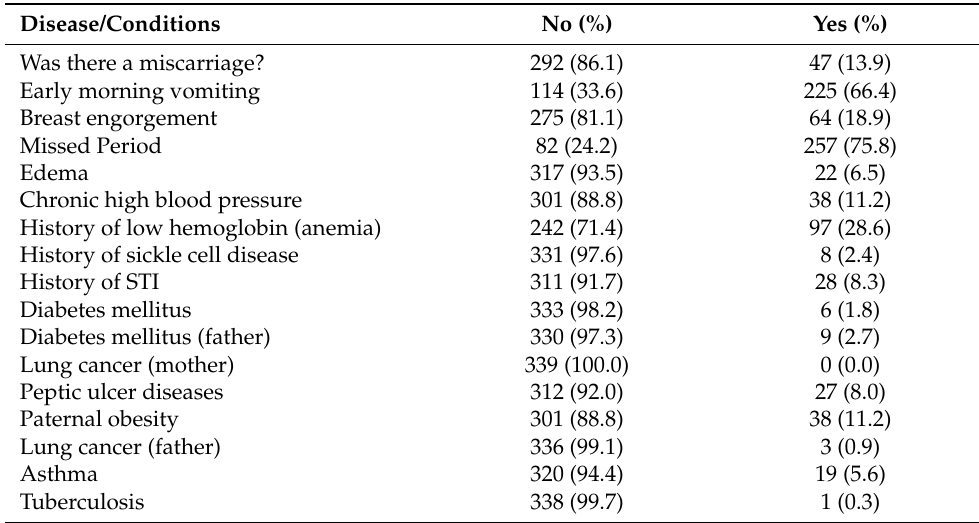
Table 2. The health profile of the mother during preconception and conception (including obstetric and medical